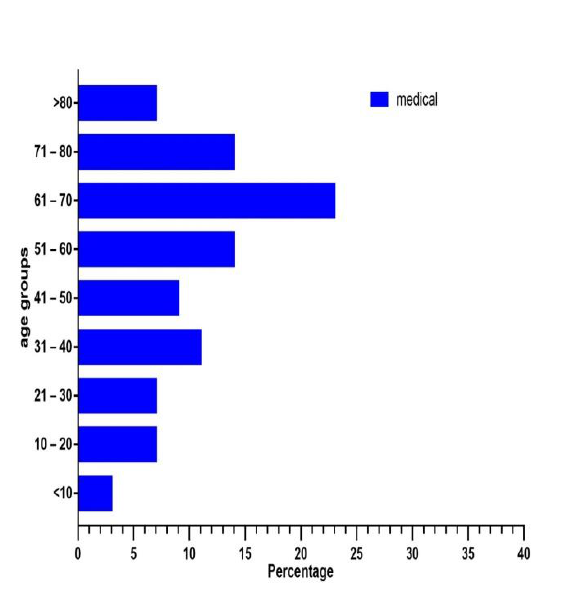
Figure 1: age groups in medical ER unit T a b l e 2 : s o u r c e o f r e f e r r a l ,